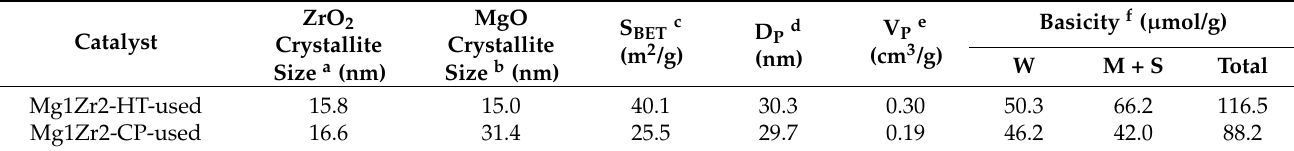
Table 4. Texture properties and surface basicity of Mg1Zr2-HT-used and Mg1Zr2-CP-used.